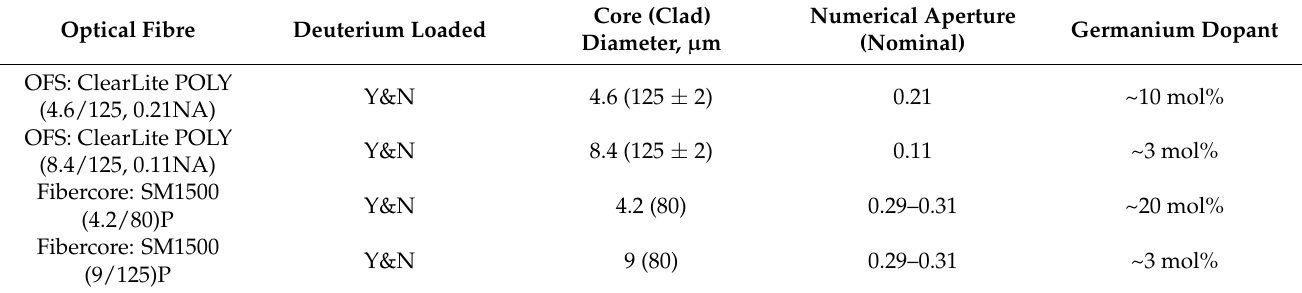
Table 1. Optical fibre